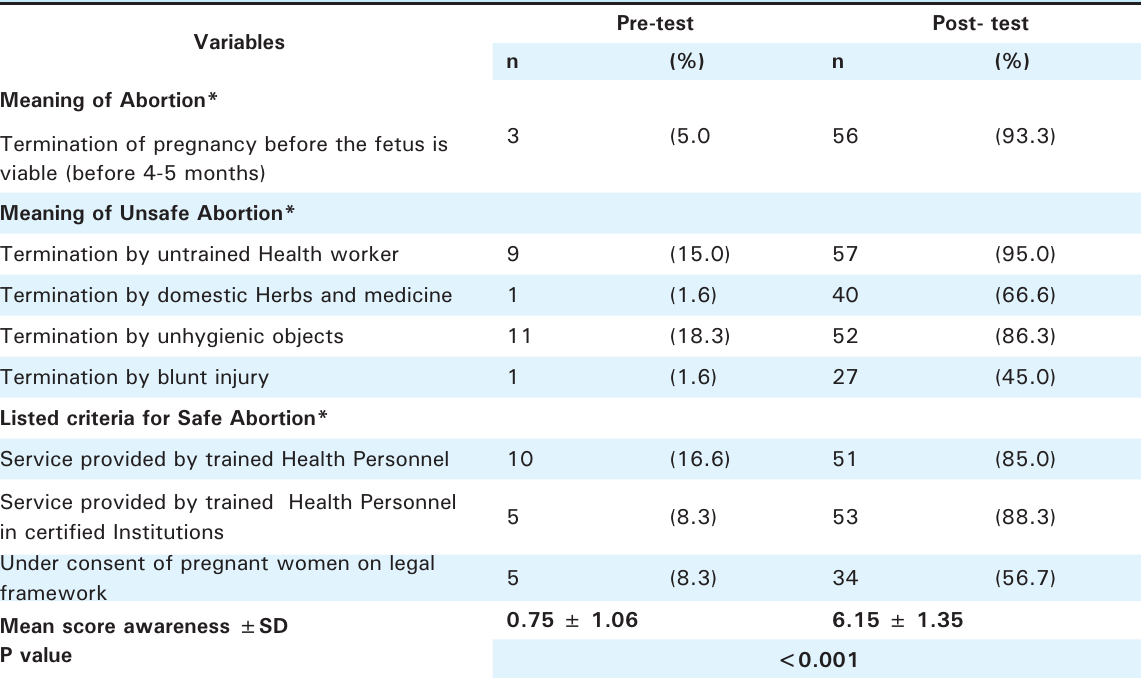
Table 2. Pre-Test and Post-Test Awareness of Respondents on Meaning of Abortion, Unsafe Abortion And Safe Abortion